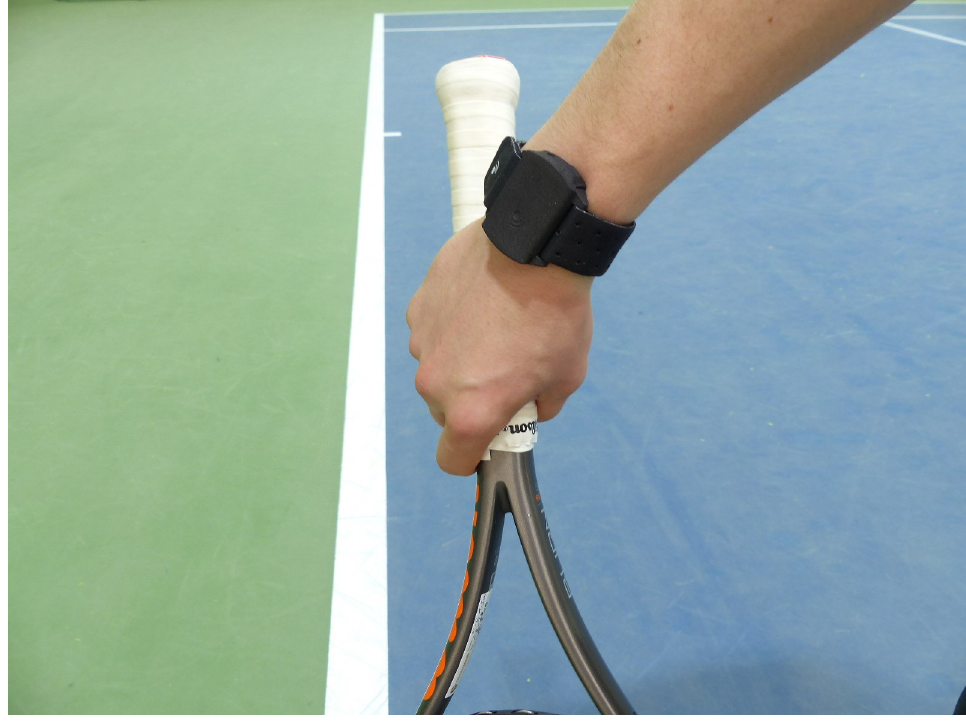
Fig 1. Placement of the